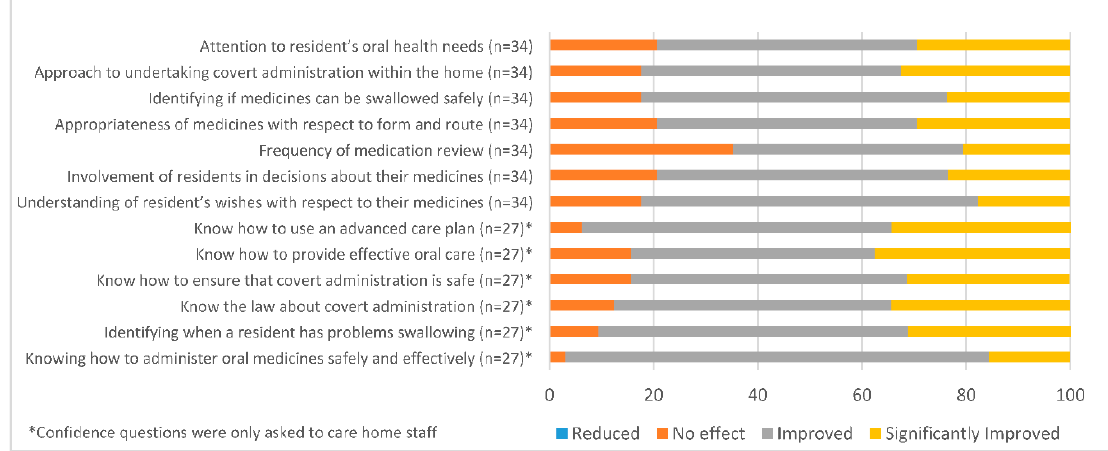
Figure 1. Reported effect of confidence of charter on care home staff and perceived impact of charter on both care home staff and residents.